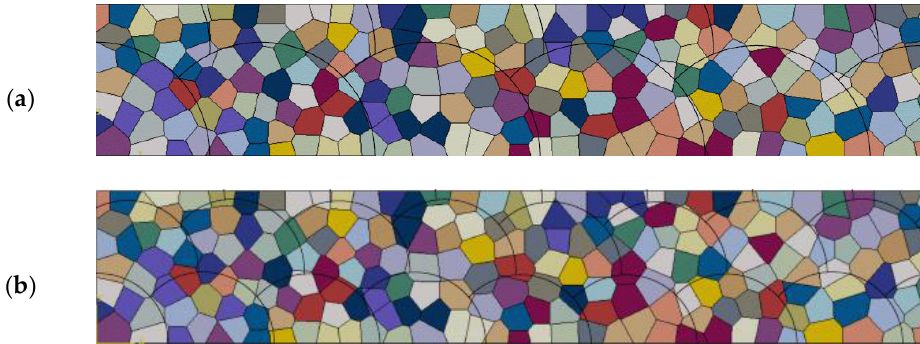
Figure 8. Models with different numbers of pools and 199 grains in T 11 : ( a ) contains 12 melt pools; ( b ) contains 25 melt pools.